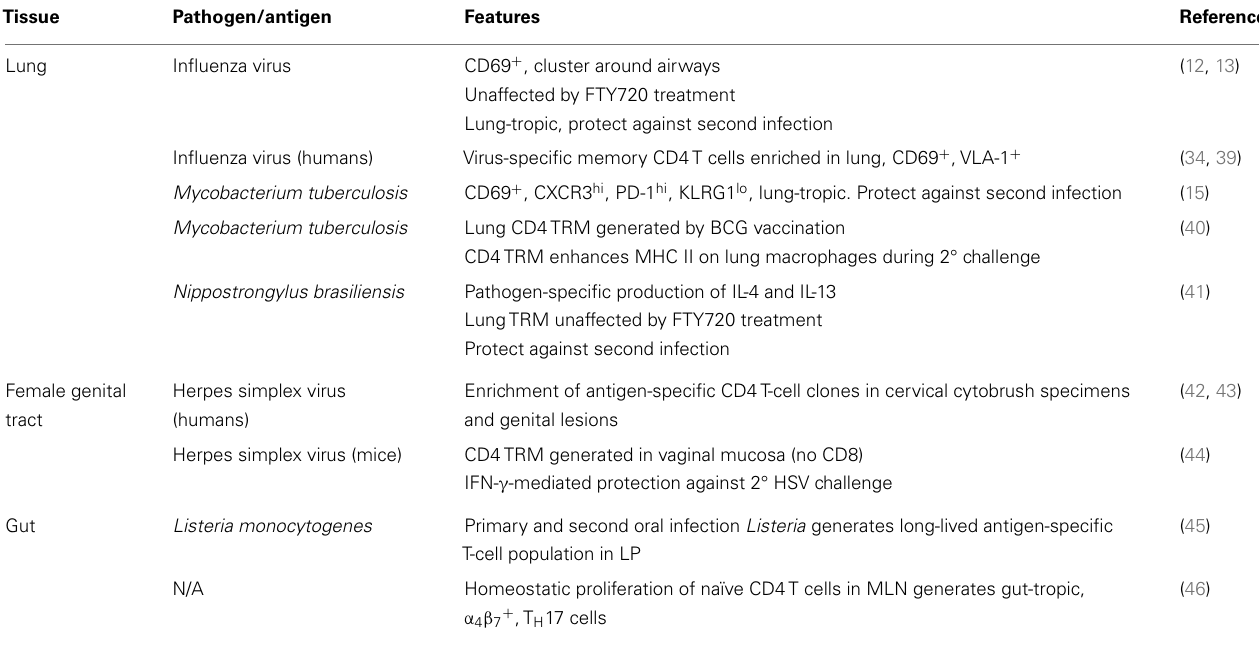
Table 1 | Observations of CD4TRM in mucosal tissues